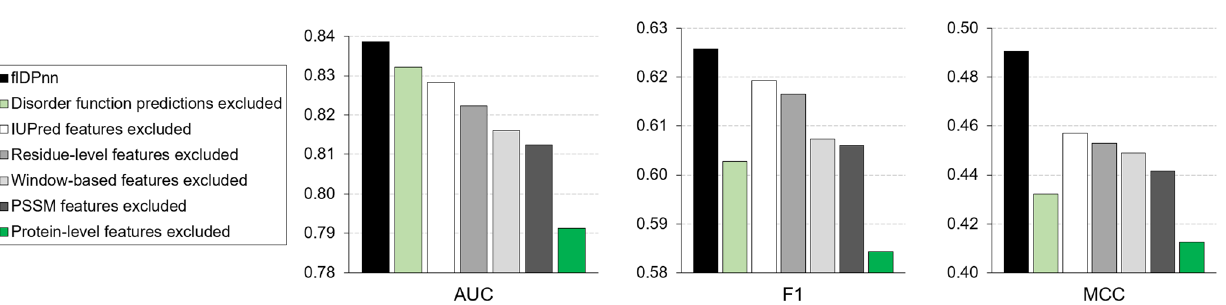
Fig. 2 Comparson of predictive performance between fl DPnn and other disorder predictors. Assessment of the disorder predictions in the CAID experiment ( A ) and on the test dataset ( B and C ) and the predictions of the fully disordered proteins in the CAID experiment ( D ) and on the test dataset ( E ). AUC (area under the ROC curve); MCC (Matthews correlation coef fi cient). The predictive quality of the putative disorder propensities is quanti fi ed with AUC (green lines) and ROC curves ( C ). The ROC curves are color-coded where fl DPnn is shown in red, ESpritz in violet, SPOT-Disorder-Single in dark green, IUPred2A-short in light green, IUPred2A-long in blue and random predictor in gray. The quality of the binary disorder predictions is assessed with MCC and F1 scores (blue bars). Panels A and D are reproduced from Fig. 2, Table 1, and Supplementary Table 5 from the CAID publication 29 .